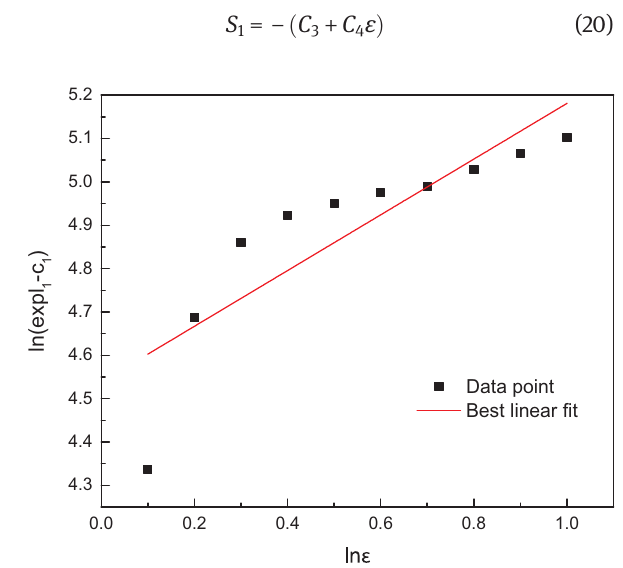
Figure 12: Relationship between ln expl 1 − C 1 ð Þ and ln ε